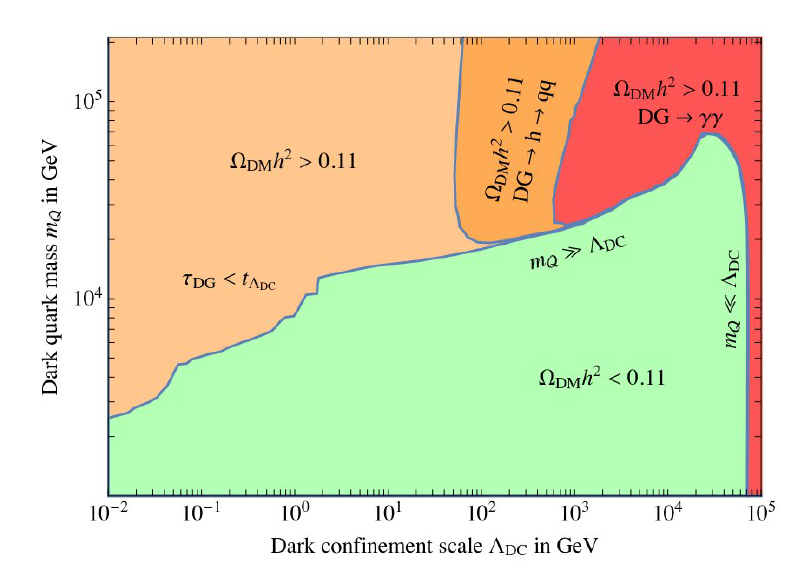
Figure 23: Regions of dark quark mass m versus confinement scale Λ (cid:48) relevant for Q the relic density of dark baryons, for gauge group SU(3), from Ref. [ 130 ] . Observed abundance is along the boundary of the green